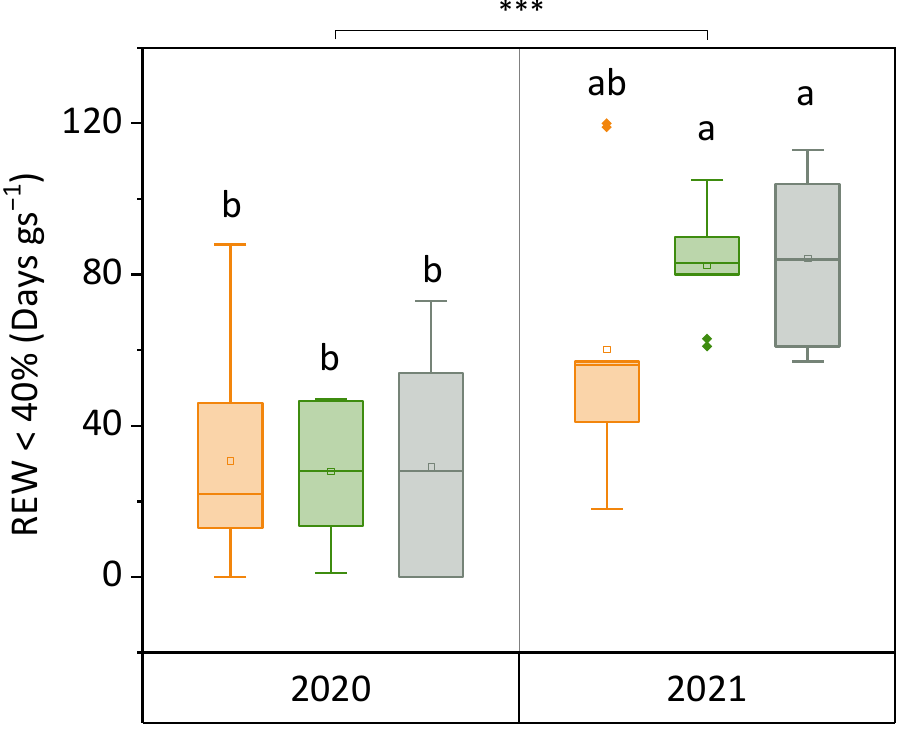
Figure 3. Sum of the number of days with REW < 40% (0–100 cm depth) during the growing season (gs) as a mean of the years 2020 and 2021 in the three planting soils ‘Sand‘ (orange), ‘FLL‘ (green), and ‘Loamy Silt‘ (grey). Statistical analyses were performed by using a two-way ANOVA. Boxes with the same letters indicate no significant differences between the substrates at the p ≤ 0.05 level. *** indicates significant differences between the years at the p ≤ 0.001 level. Mean comparisons were performed by Tukey post hoc comparisons.